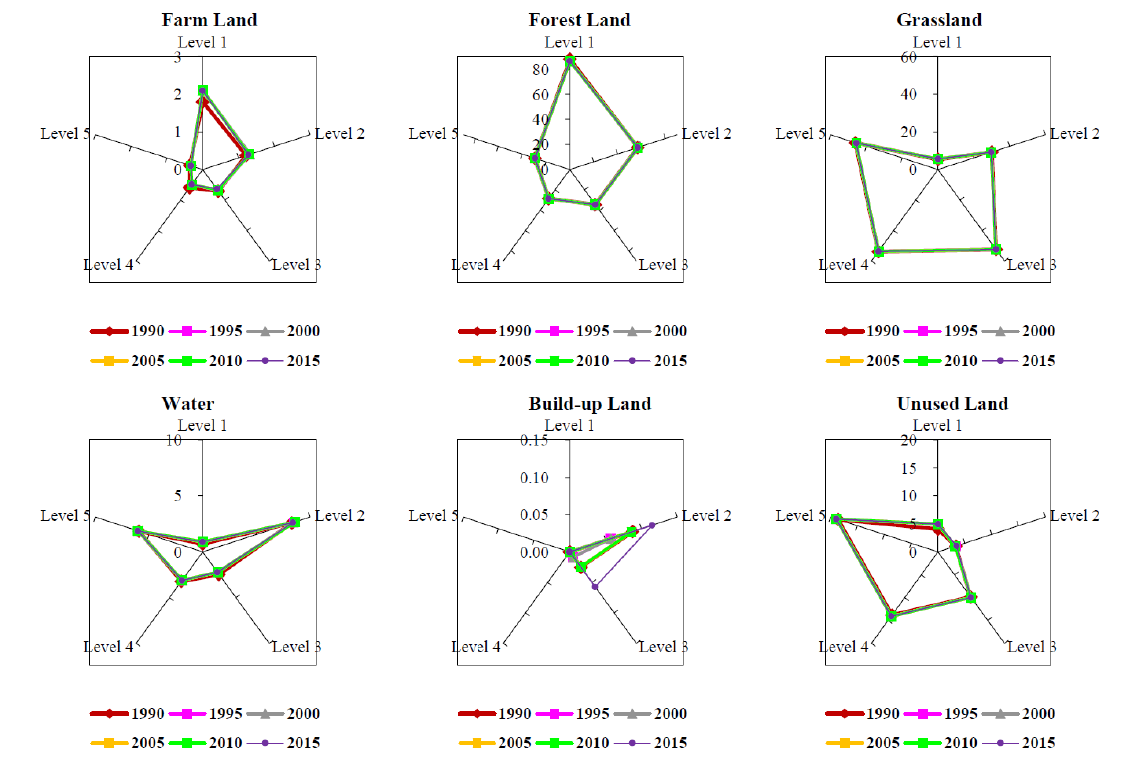
Figure 3. Ratio of ecosystem area in Shannan based on terrain gradients. Table 1. Variation in ecosystem based on terrain gradient from 1990 to 2015 (%).